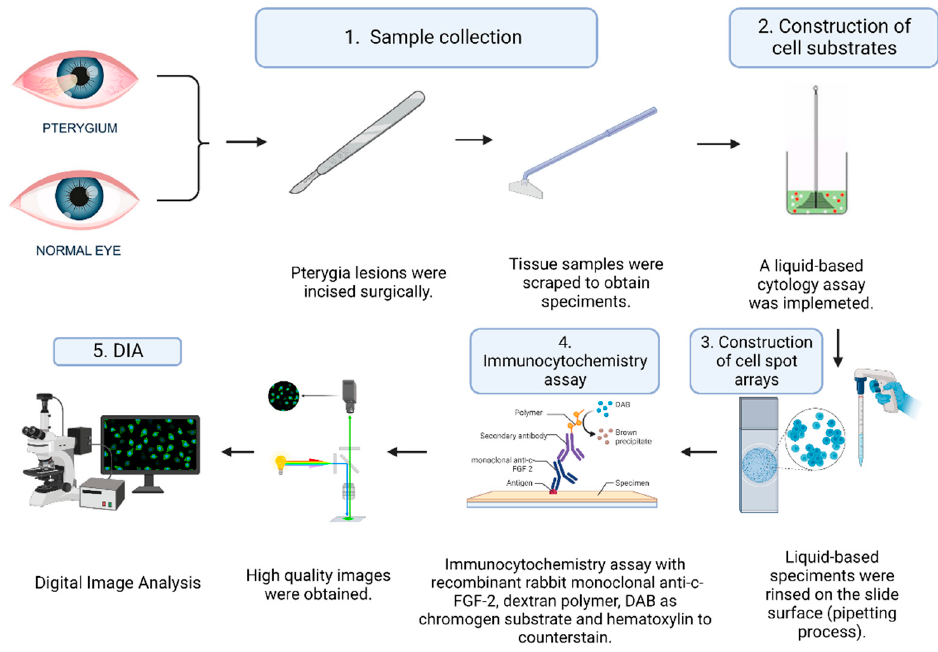
Figure 1. The specimen collection and analysis procedure. FGF: Fibroblastic Growth Factor; DAB: 3-3, diaminobenzidine tetrahydrochloride.